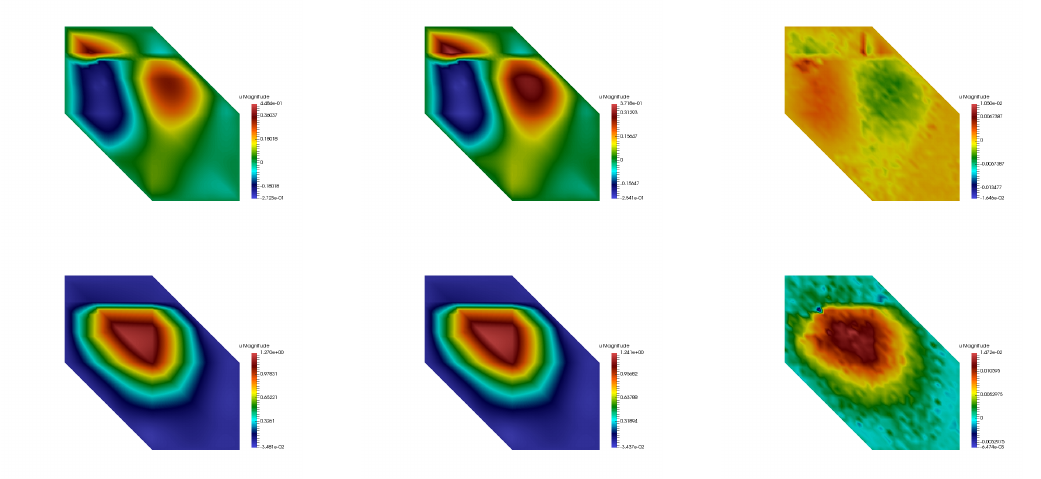
, respecitvely. and the second basis function φ ω 1 2 1